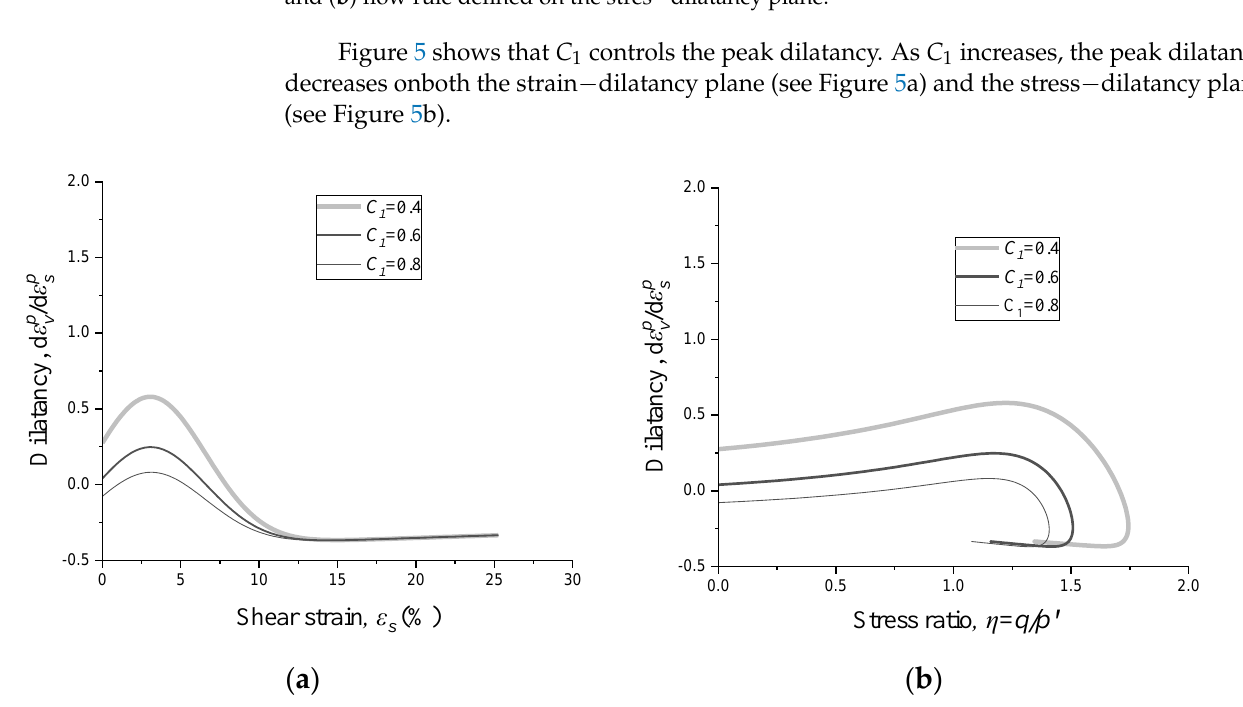
Figure 5. Effect of C 1 on dilatancy: ( a ) flow rule defined on the plane of dilatancy versus shear strain, and ( b ) flow rule defined on the stress − dilatancy plane.